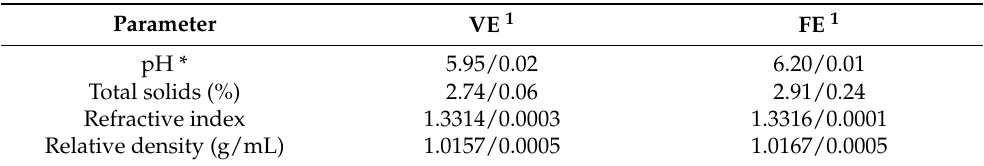
Table 2. Physicochemical parameters of the aqueous extract from the X. caeruleum leaves collected in vegetative (VE) and flowering (FE)